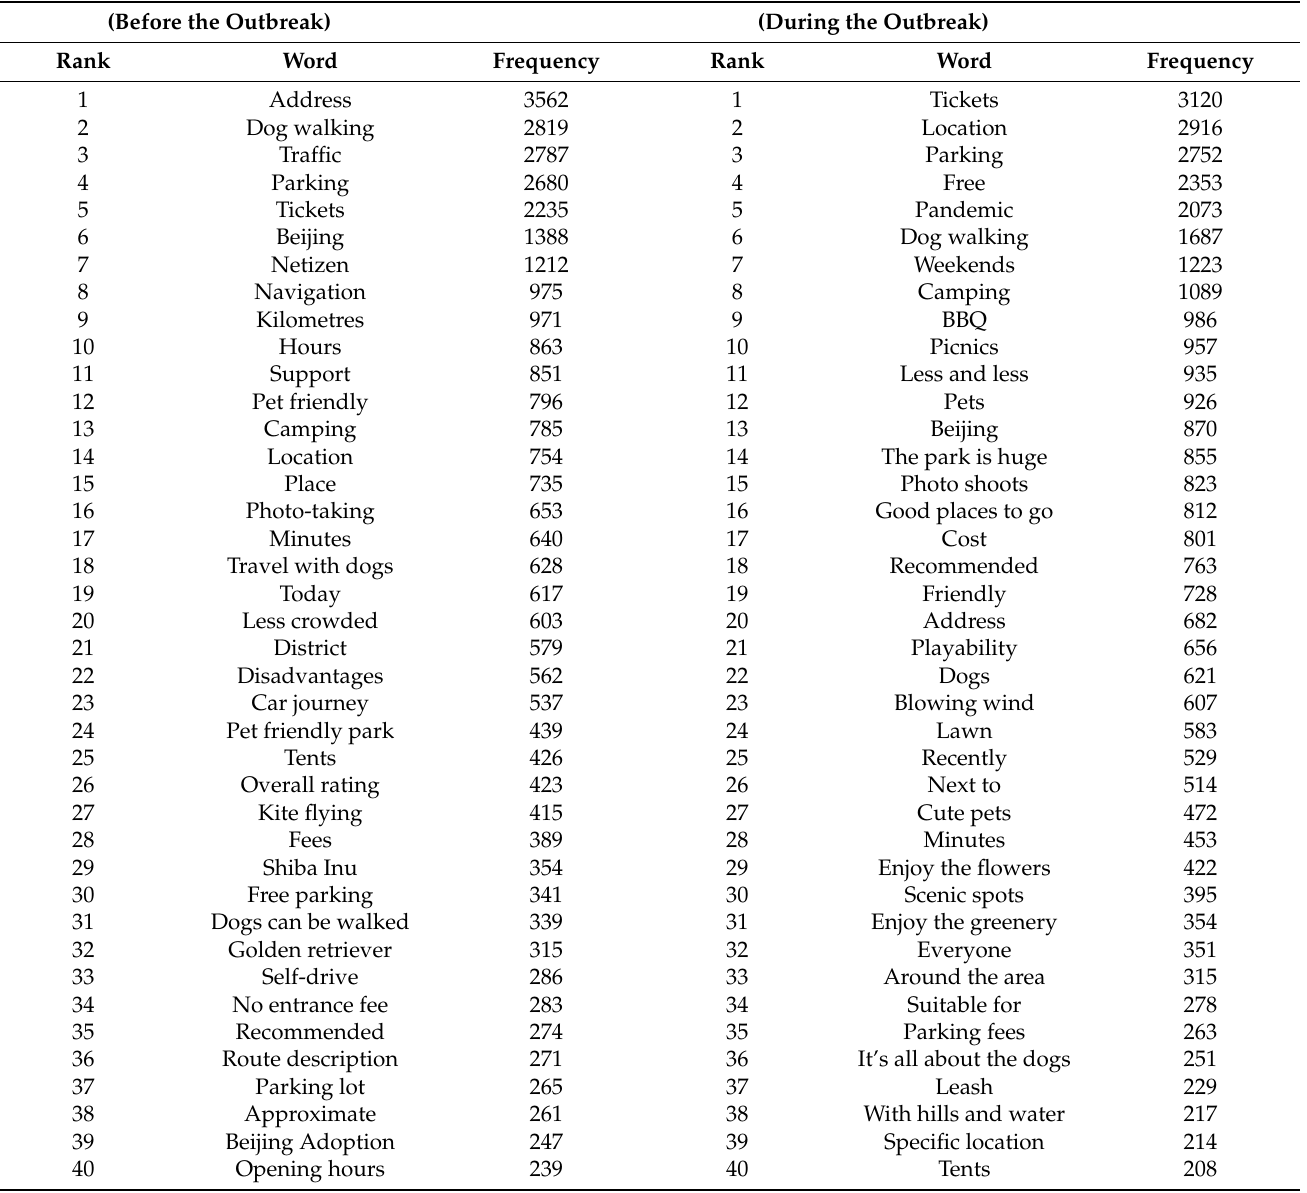
Table 1. Frequency statistics for the top 40 words before and during the